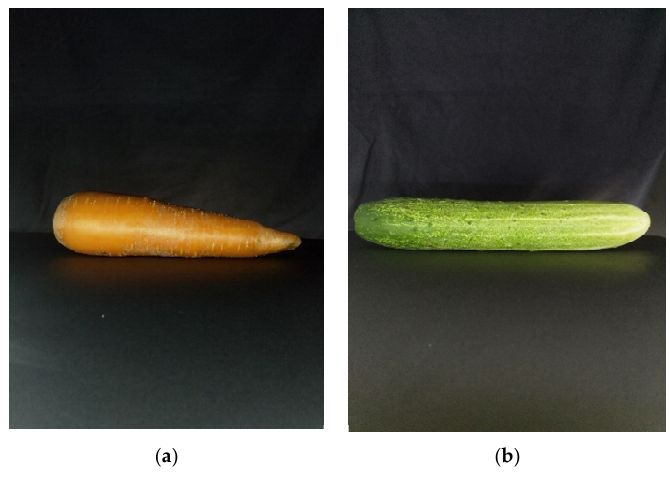
Figure 20. Side view images: ( a ) carrot, ( b ) cucumber.